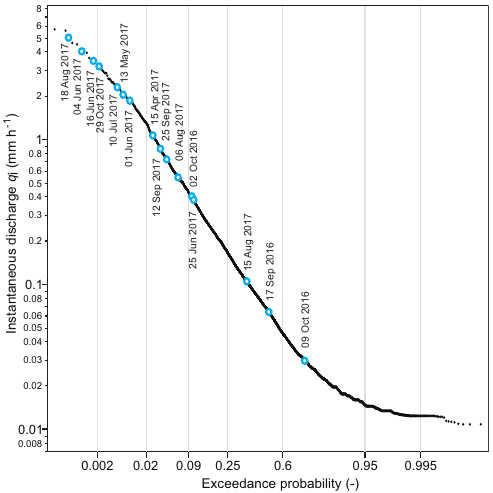
Figure 3. Flow duration curve of Erlenbach for the combined study periods 15 September to 6 November 2016 and 7 May to 1 Novem- ber 2017. Blue data points indicate the hourly peak flow rates of 16 storm events analysed in this study, showing that widely varying flow conditions were captured in our data set. For the sake of read- ability, the remaining eight events are not included in the graph, be- cause they share very similar hourly peak flow rates to those events depicted here.